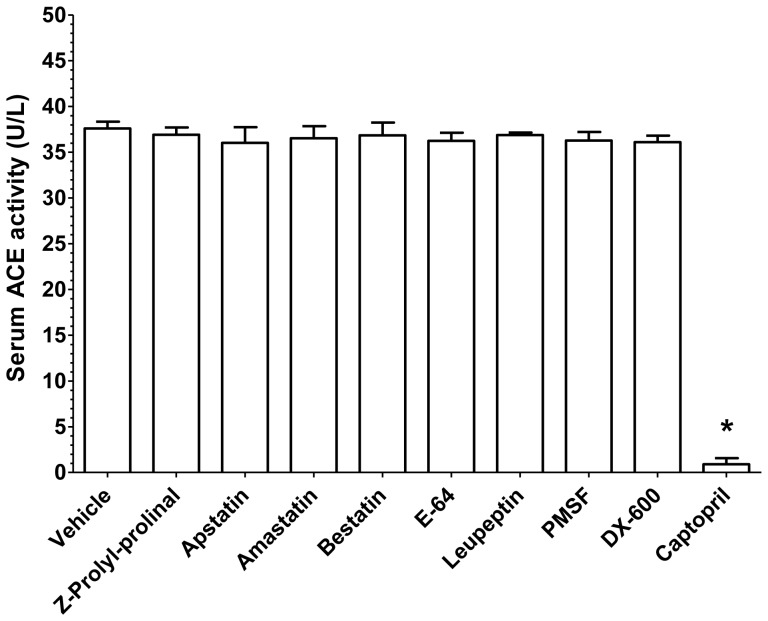
Effects of various protease inhibitors on FAPGG hydrolysis by human serum.Human serum (8-fold dilution) was incubated with Z-Prolyl-prolinal (prolyl-endopeptidase inhibitor, 1 µM), Apstatin (aminopeptidase P inhibitor, 10 µM), Amastatin (an inhibitor of various aminopeptidases, 10 µM), Bestatin (leucin aminopeptidase and aminopeptidase B inhibitor, 1 µM), E-64 (cysteine protease inhibitor, 1 µM), Leupeptin (serine and cysteine protease inhibitor, 10 µM), PMSF (serine and cysteine protease inhibitor, 100 µM), DX-600 (ACE2 inhibitor, 1 µM) and captopril (an ACE inhibitor, 1 µM) for 15 min. ACE activity measurement was initiated by the addition of FAPGG. Enzyme activity was measured for 120 min and apparent enzyme activities were expressed and plotted in absolute (U/L) units. Bars represent mean ± SEM of three independent determinations. Significant difference (p<0.001) from the control (vehicle) is indicated by the asterisk.